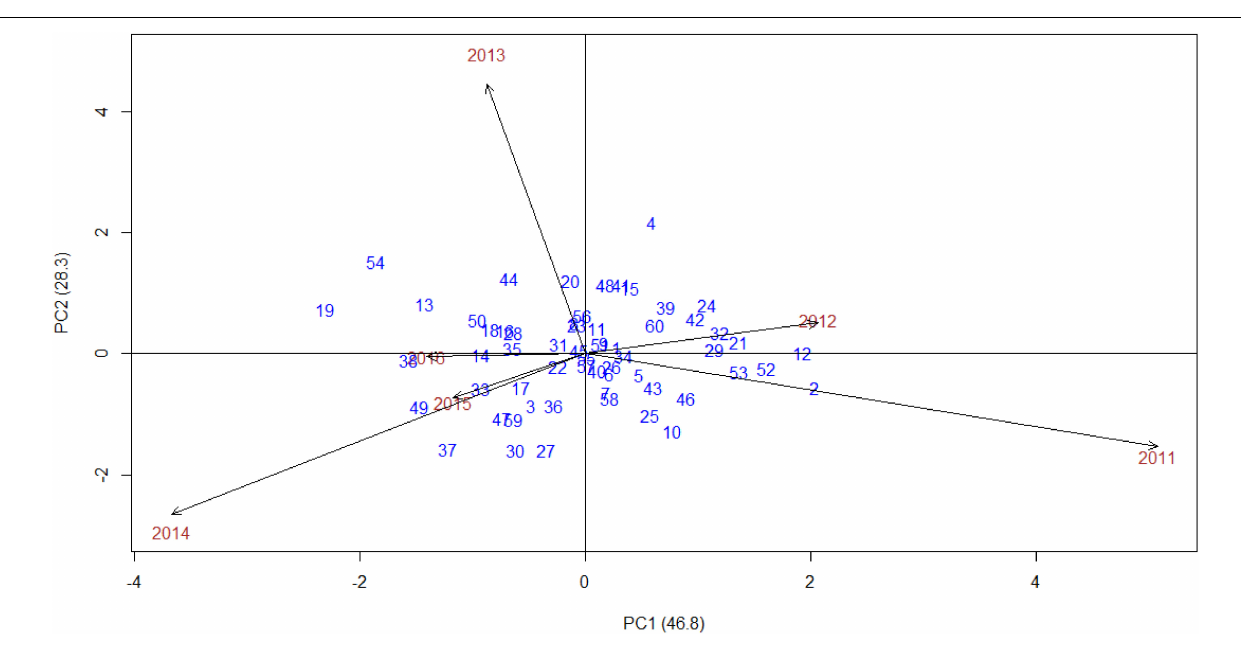
Frontiers in Plant Science |